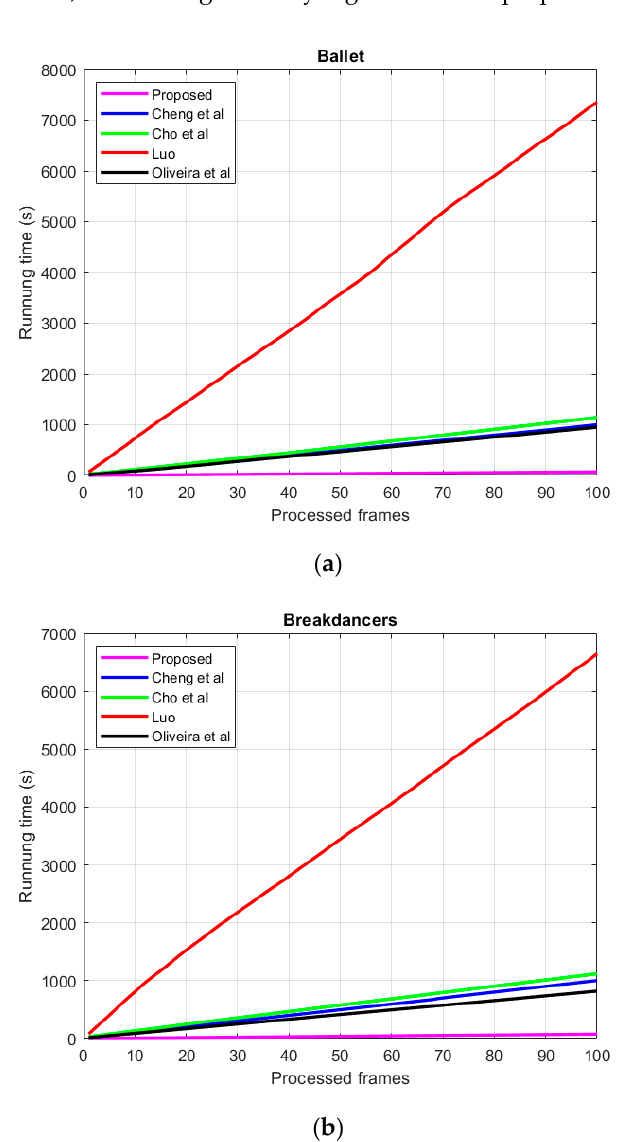
Figure 15. Cumulative execution times corresponding to the number of frames compared with our proposed method, and the methods of Chang et al. [21], Cho et al. [19], Luo and Zhu [26], and Oliveira et al. [27] ( a ) Ballet video and ( b ) Breakdancers video.